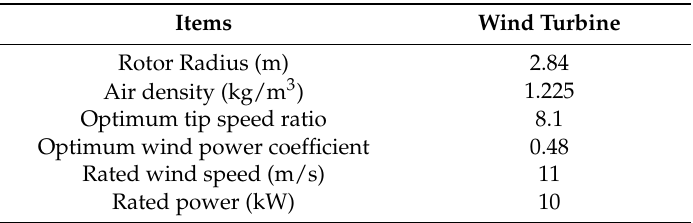
Table 1. Parameters of the wind turbine.